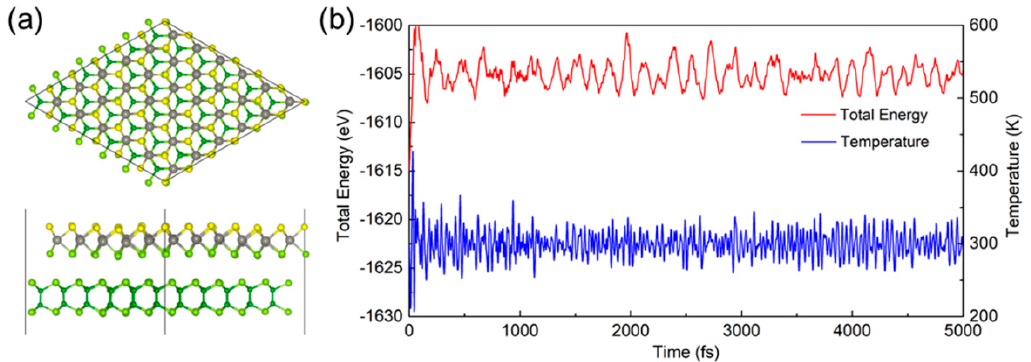
Figure 3. ( a ) The AIMD snapshots for the WSSe/BSe vdW heterostructure; ( b ) the total energy and temperature fluctuations during AIMD simulations for the WSSe/BSe heterostructure.